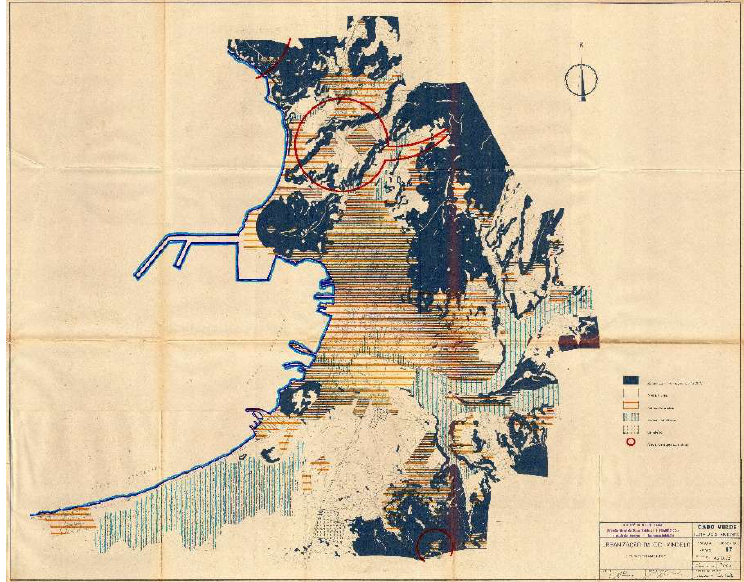
Figure 6. Maria Emília Caria. “Urban Development Plan for Mindelo, São Vicente island, Cape Verde, Figure 6. Maria Em í lia conditioning factors”, drawing no. 17, 1969, Town Planning and Housing, General Council for Public Works and Communications, Lisbon, Ministry of Overseas Affairs, AHU: PT/IPAD/MU/DGOPC/ DSUH/2060/07216. (Credits: Portugal, Overseas Historical Archive—PT-AHU, used with permission).